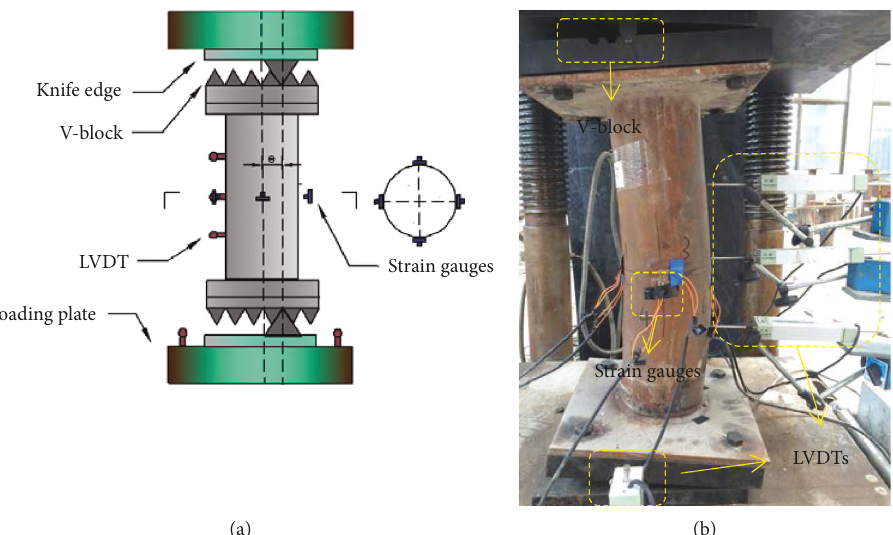
Figure 1: Test setup and strain measuring point arrangement: (a) schematic diagram of test setup; (b) Test